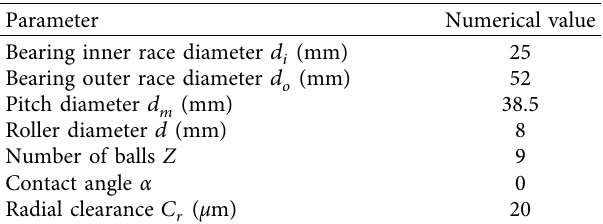
Figure 6: Bearing fault test rig. (a) Experimental setup. (b) Schematic drawing of the experimental setup. Table 1: 6205-2RS JEM SKF bearing structural